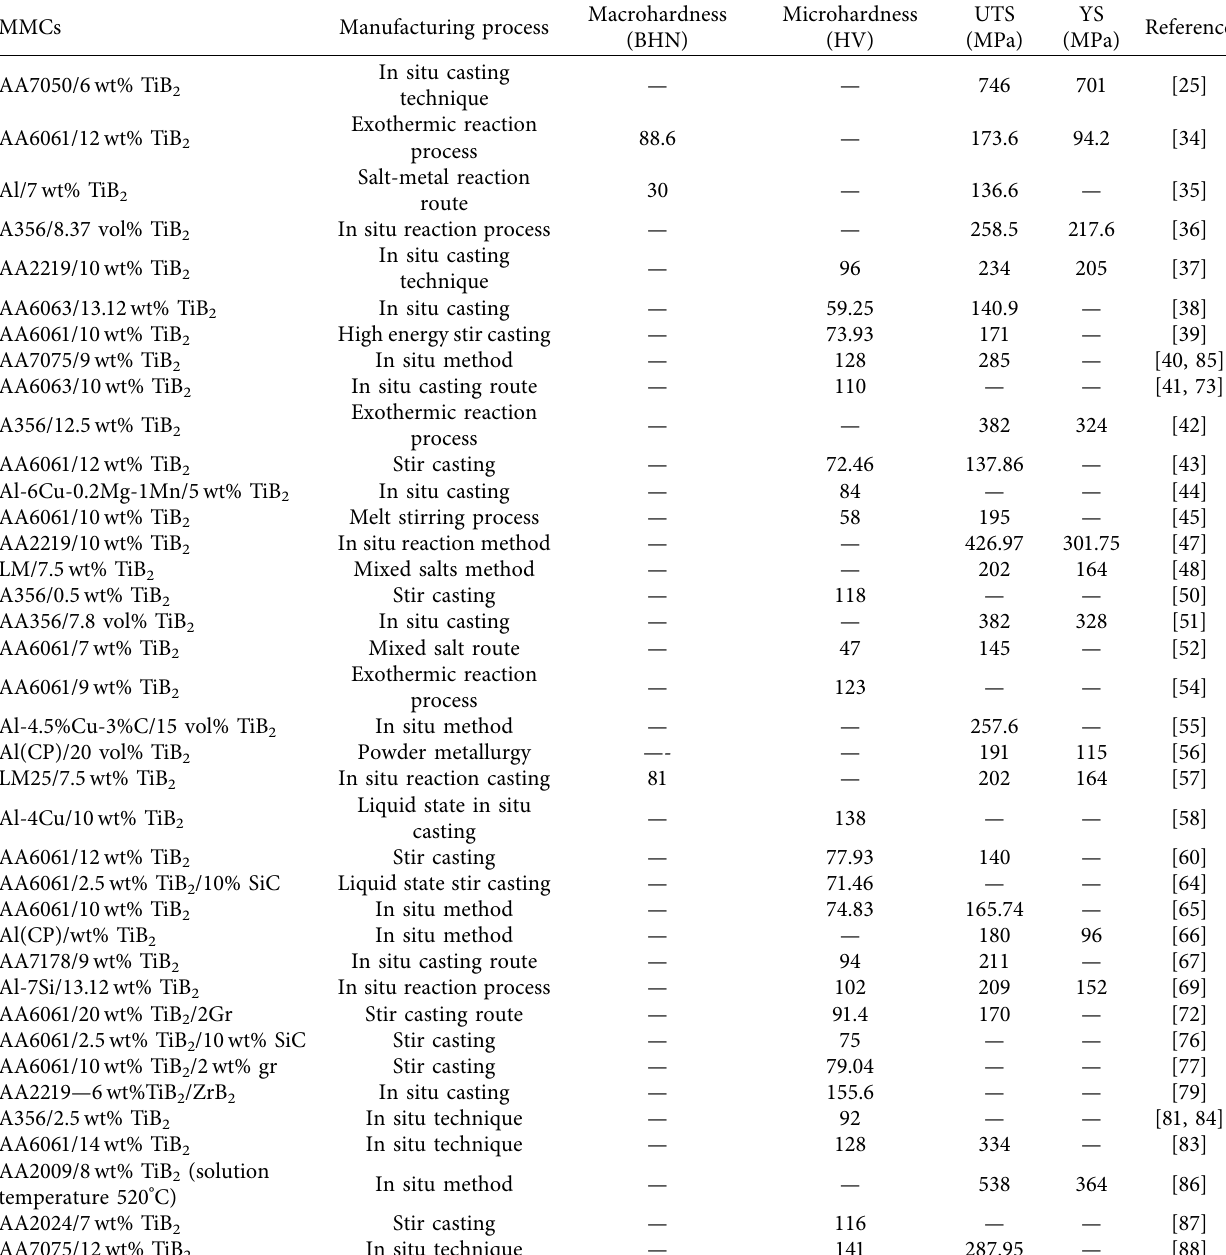
Table 3: Superior mechanical properties of titanium diboride based aluminum matrix